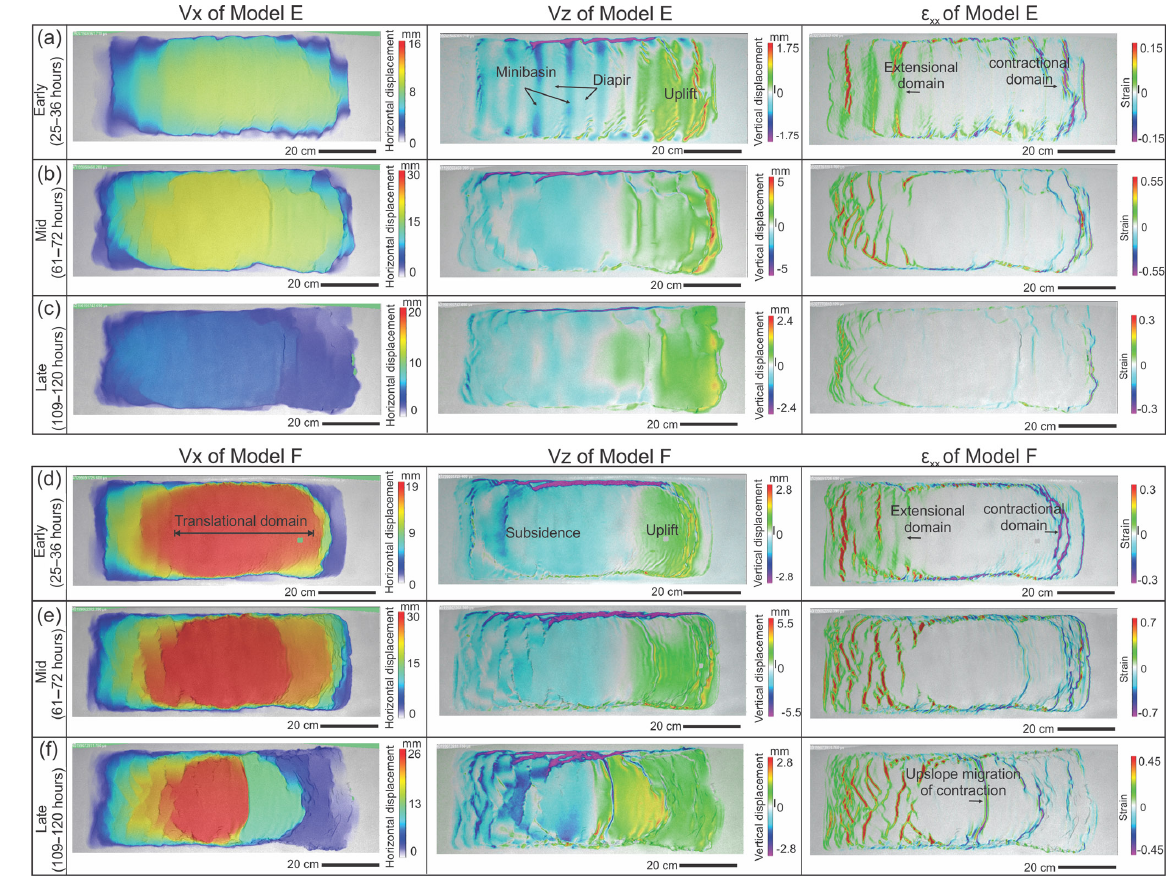
Figure 8. ( a – c ) Map view of incremental horizontal and vertical displacement ( V x , V z ) and strain pattern ( ε xx ) derived from 3-D DIC strain data of Model E from the (a) early (25–36h), (b) middle (61–72h) and (c) late stages (109–120h). Note the minibasins and diapirs formed in the mid-slope during the early stage of the experiment. ( d – f ) Map view of incremental horizontal and vertical displacement ( V x , V z ) and strain pattern ( ε xx ) of Model F from the (d) early (25–36h), (e) middle (61–72h) and (f) late stages (109–120h). Note the overall similarity between Model F to Model C. The horizontal displacement ( V x ) displays downslope displacement of the sedimentary cover (left to right in map view). The vertical displacement ( V z ) displays total subsidence and uplift. The horizontal strain ( ε xx ) shows location of the extensional (red) and contractional (purple)